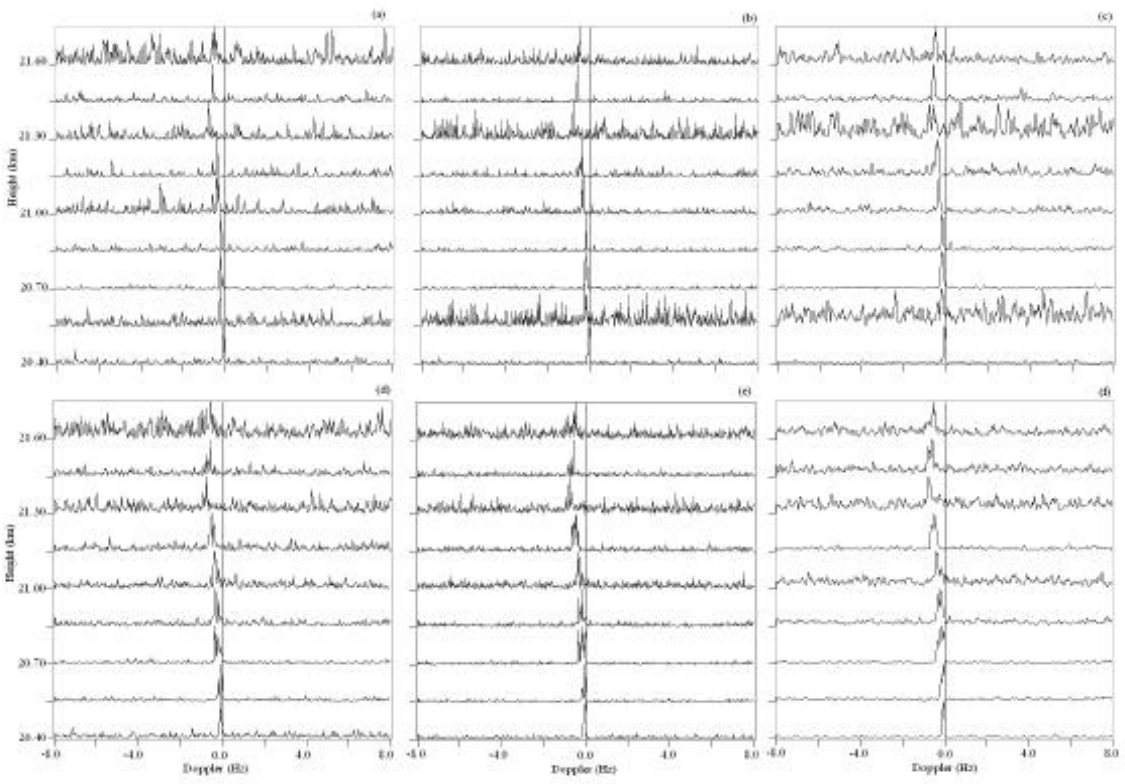
Fig. 6. Power spectra estimated (a) and (d) using Hanning taper, (b) and (e) using rectangular taper, (c) and (f) using sinusoidal taper for 1 and 3 incoherent integration, respectively.